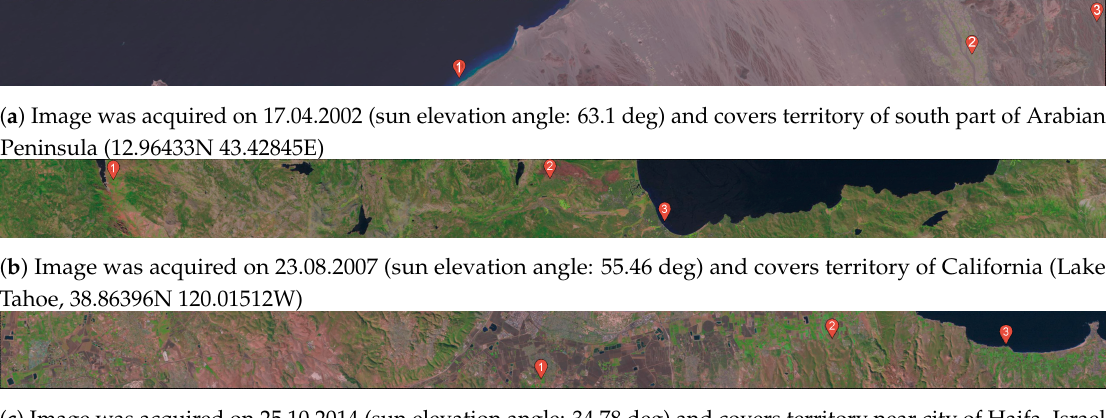
Figure 4. RGB images of the Hyperion based on retrieved spectral surface reflectance functions using the SHARC